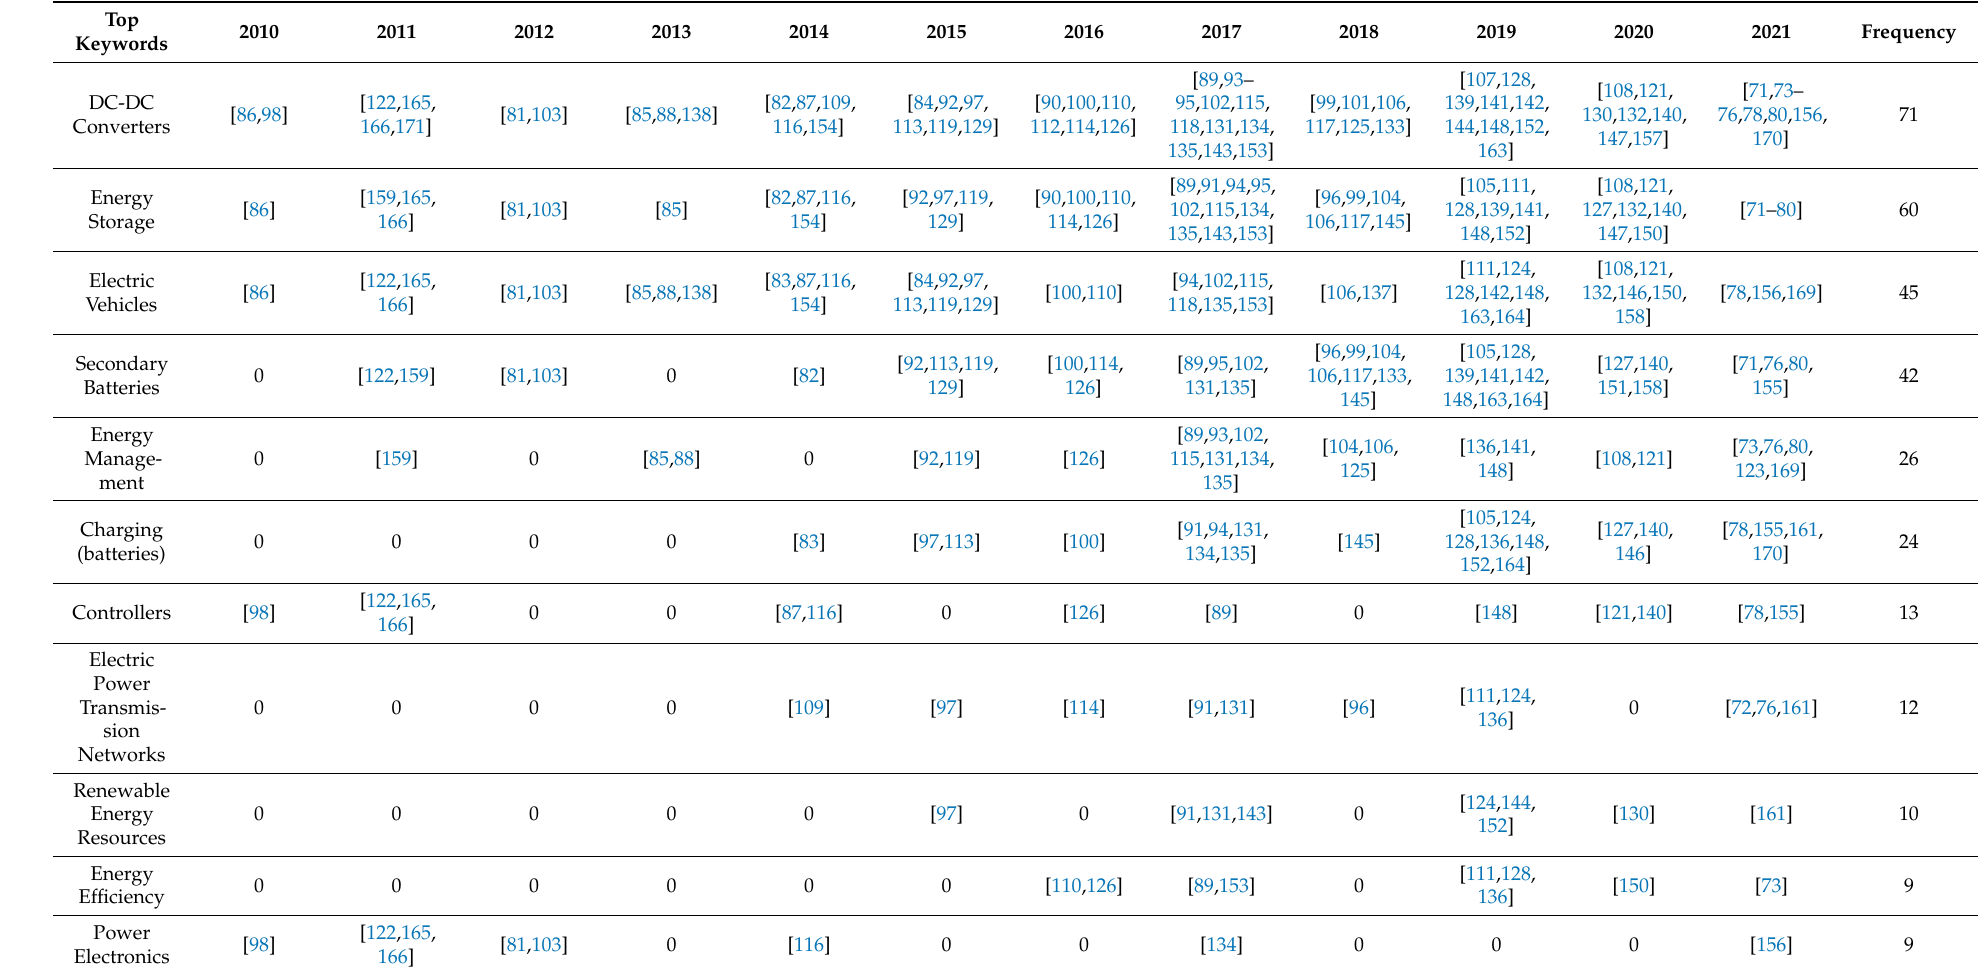
Table 4. Top-most 15 keywords from the selected 100 manuscripts between 2010 and